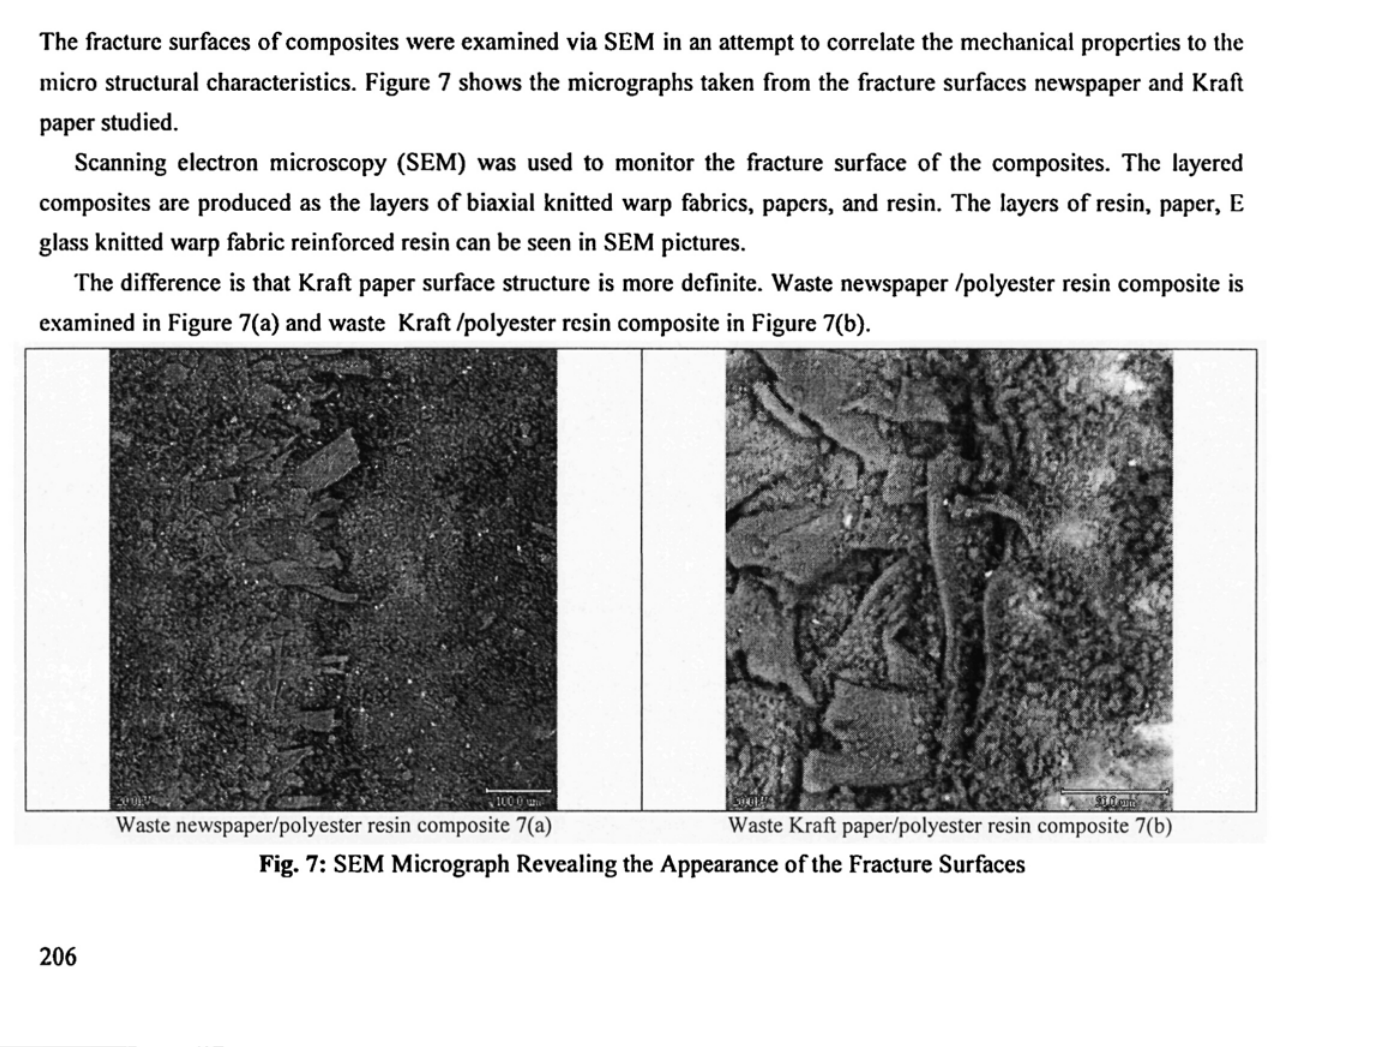
Fig. 7: SEM Micrograph Revealing the Appearance of the Fracture